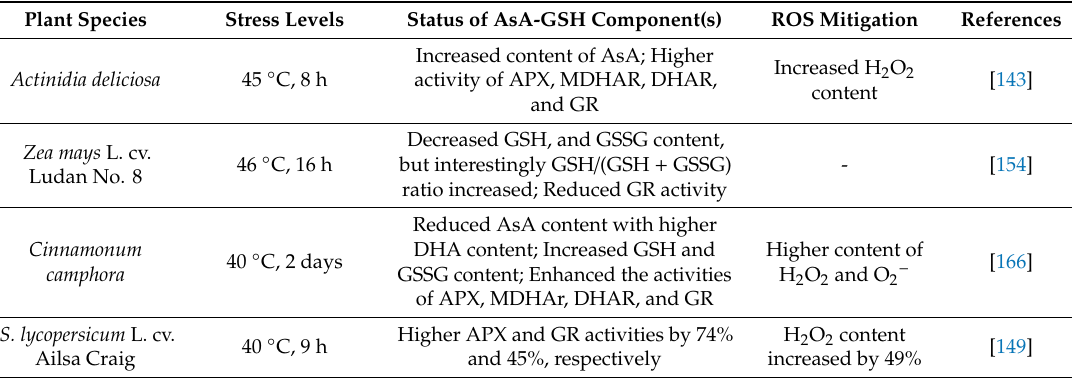
Table 3. Role of AsA-GSH in regulating oxidative stress under extreme temperature, flooding, and atmospheric